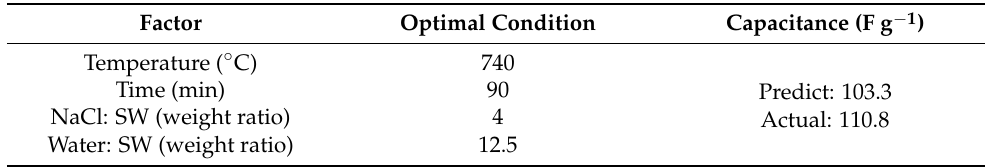
Table 5. The optimal preparatory conditions after software analysis. Factor Optimal